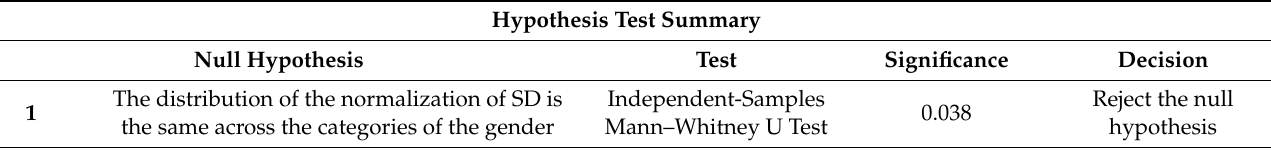
Table A6. Mann Whitney U Test Kruskal-Wills Test for Nonparametric